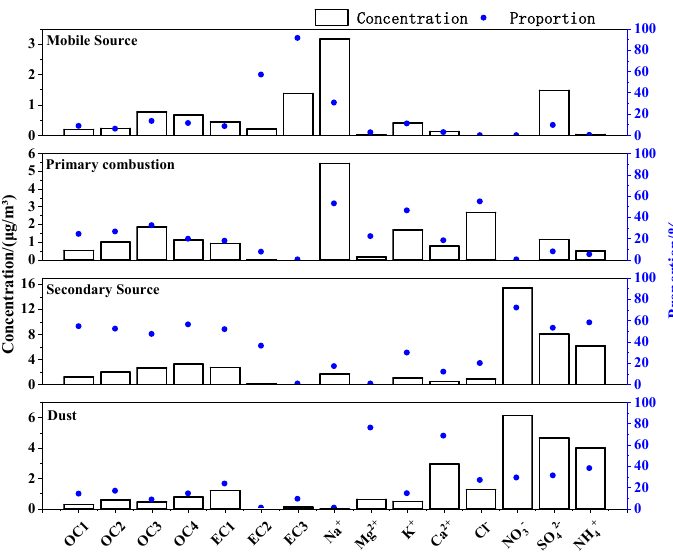
Figure 11. The source component spectra were resolved by the PMF model.